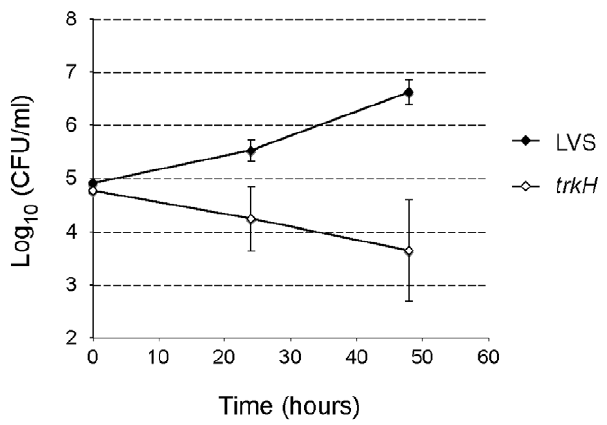
Figure 9. Multiplication of trkH mutant is impaired in murine blood ex vivo. Heparinized blood samples from eight mice were inoculated with , 5 6 10 4 bacteria ml 2 1 and incubated at 37 u C with shaking for 24 and 48 h, at which point the number of viable bacteria was determined. Closed symbols correspond to the LVS strain and open symbols the trkH